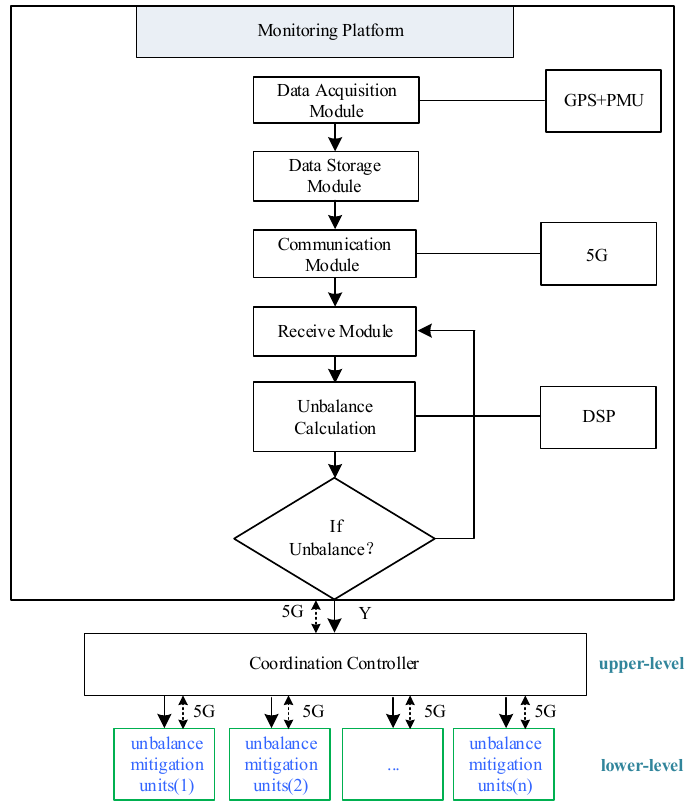
Figure 7. The block diagram of the three-phase imbalance monitoring and control scheme.